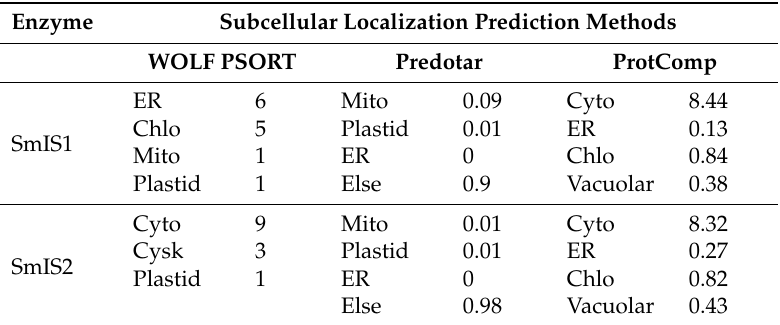
Table 2. Prediction of SmIS1 and SmIS2 subcellular localization using website programs. Enzyme Subcellular Localization Prediction Methods WOLF